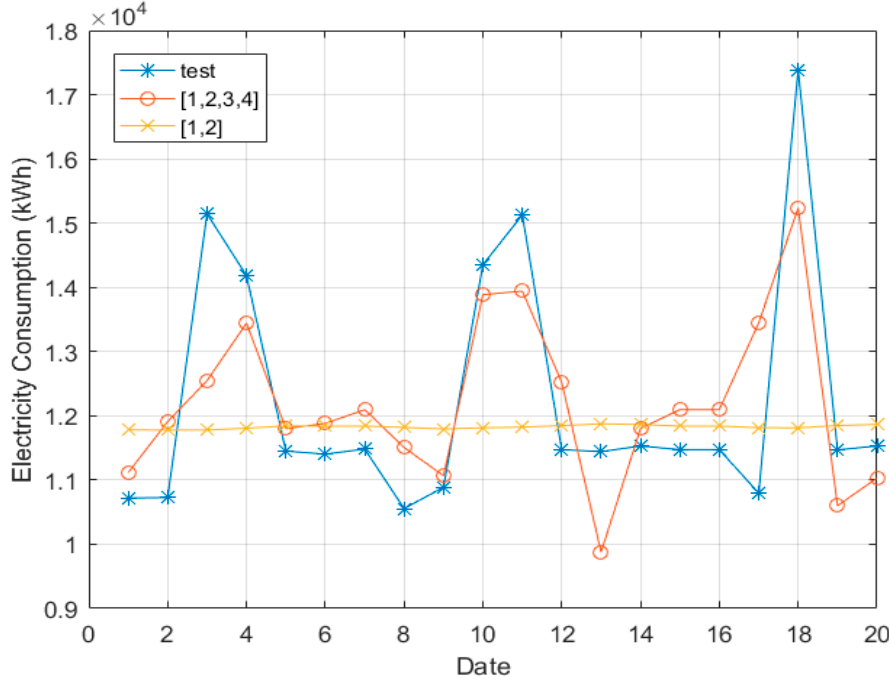
Figure 3. Test data, {1, 2, 3, 4} and {1, 2} calculation with BRNN.